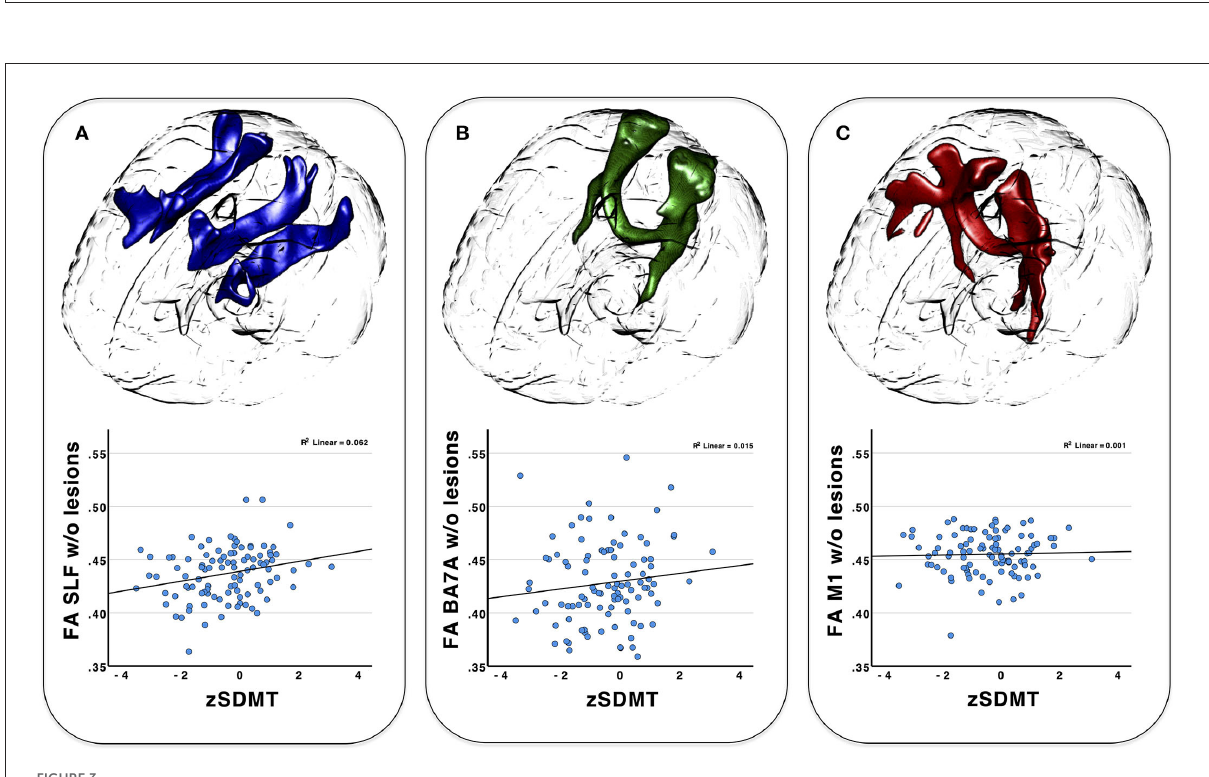
FIGURE3 3D-tractogram of all three tracts investigated (top) and the plotted correlation of behavioral data (SDMT) with the weighted mean FA of the tracts after lesion exclusion (bottom). (A) superior longitudinal fasciculus (SLF); (B) BA7A tract; (C) corticospinal tract